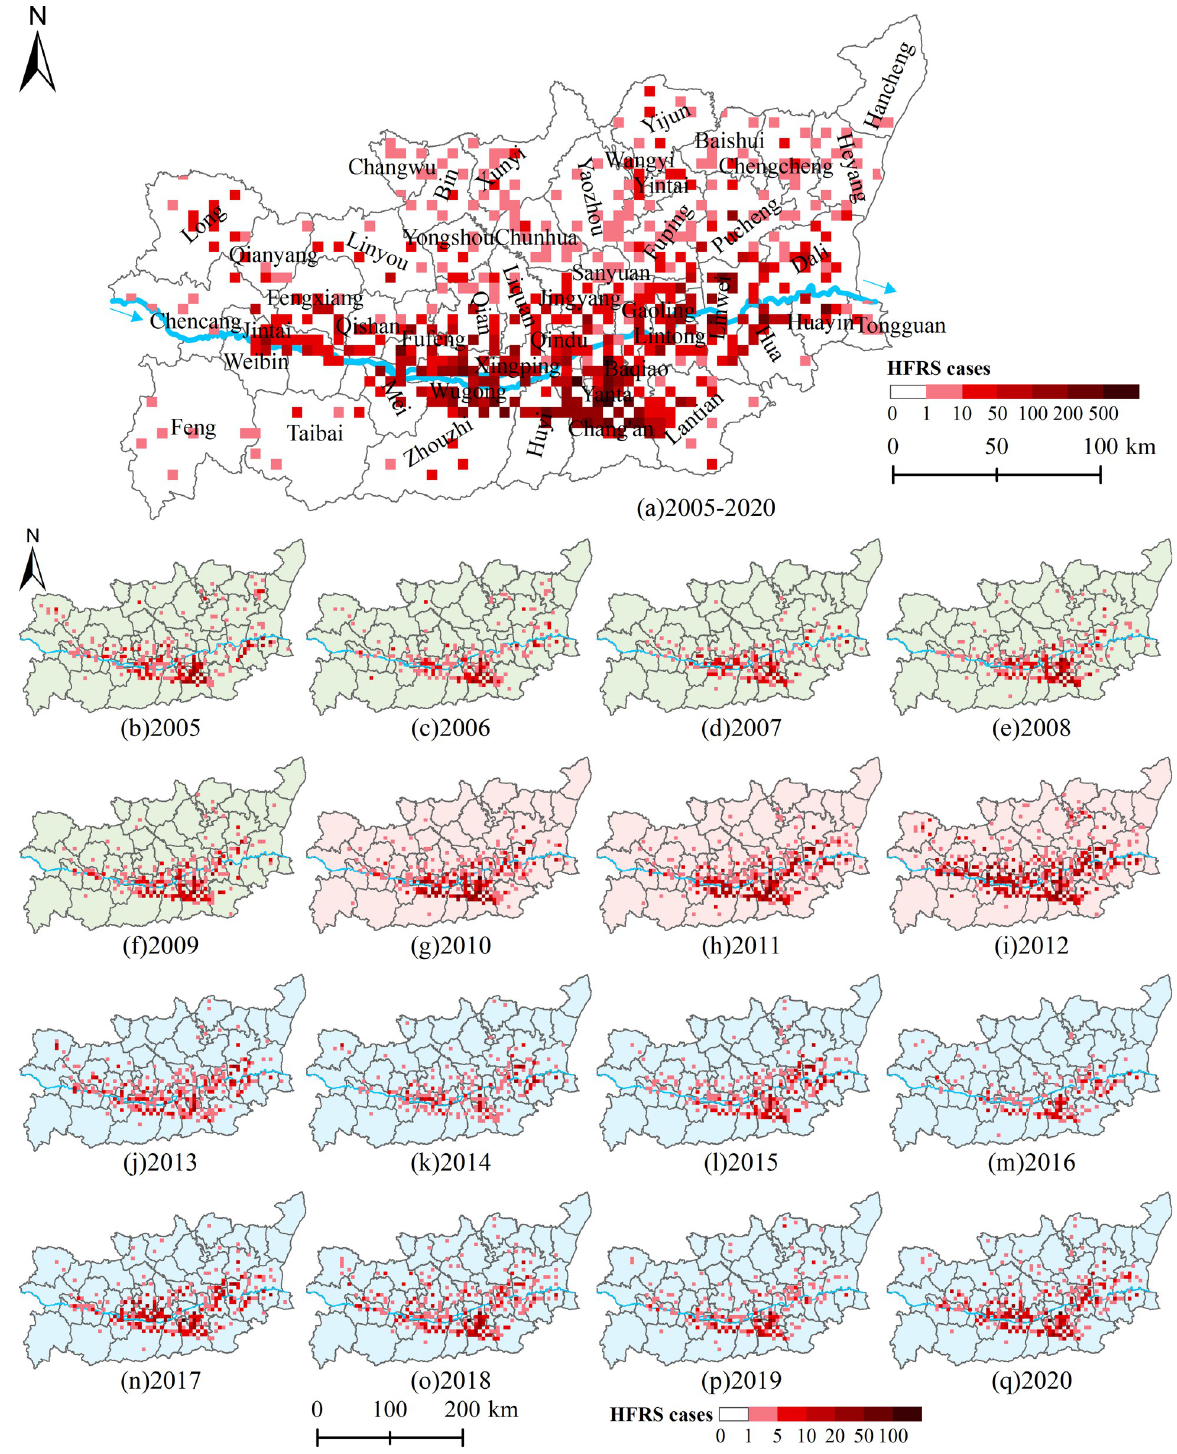
Fig 5. The number of HFRS cases at the 5-kilometer grid scale in Weihe Basin from 2005 to 2020. https://www.resdc.cn/Datalist1.aspx? FieldTyepID=20,0.